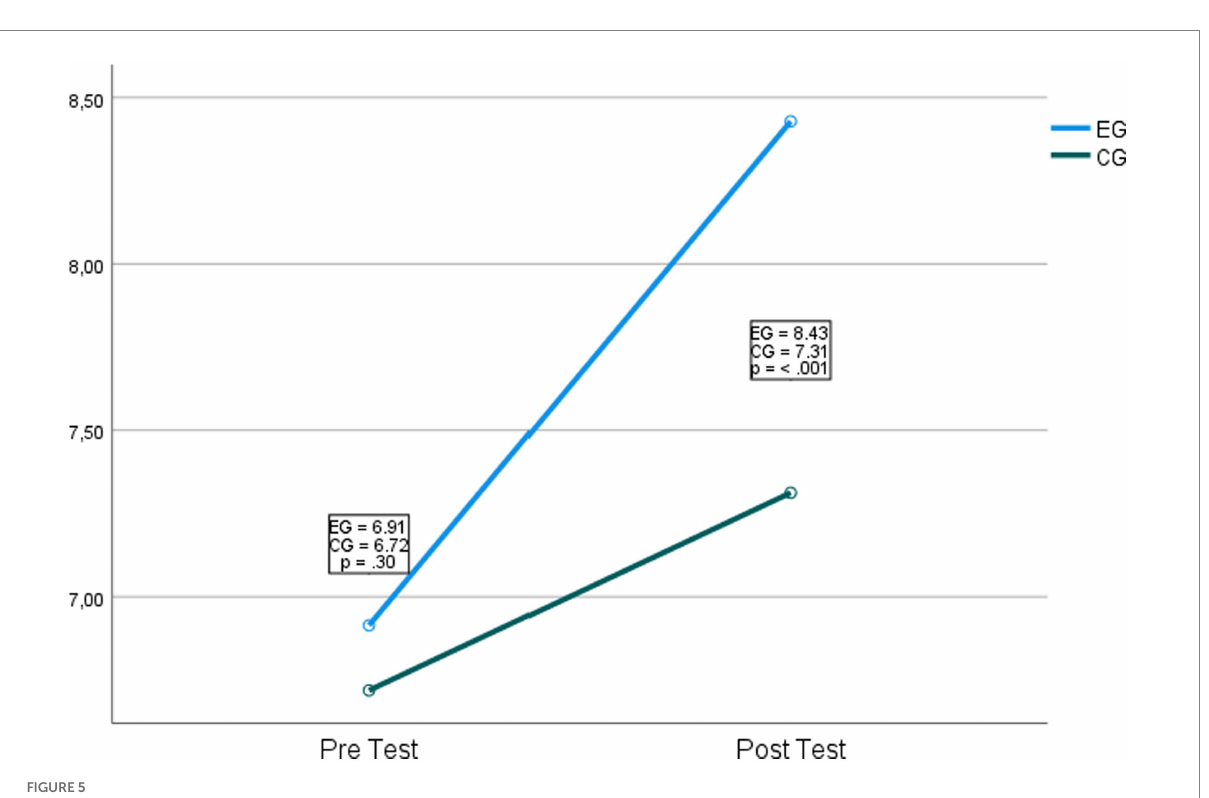
FIGURE 5 Comparison of the control and experimental groups in